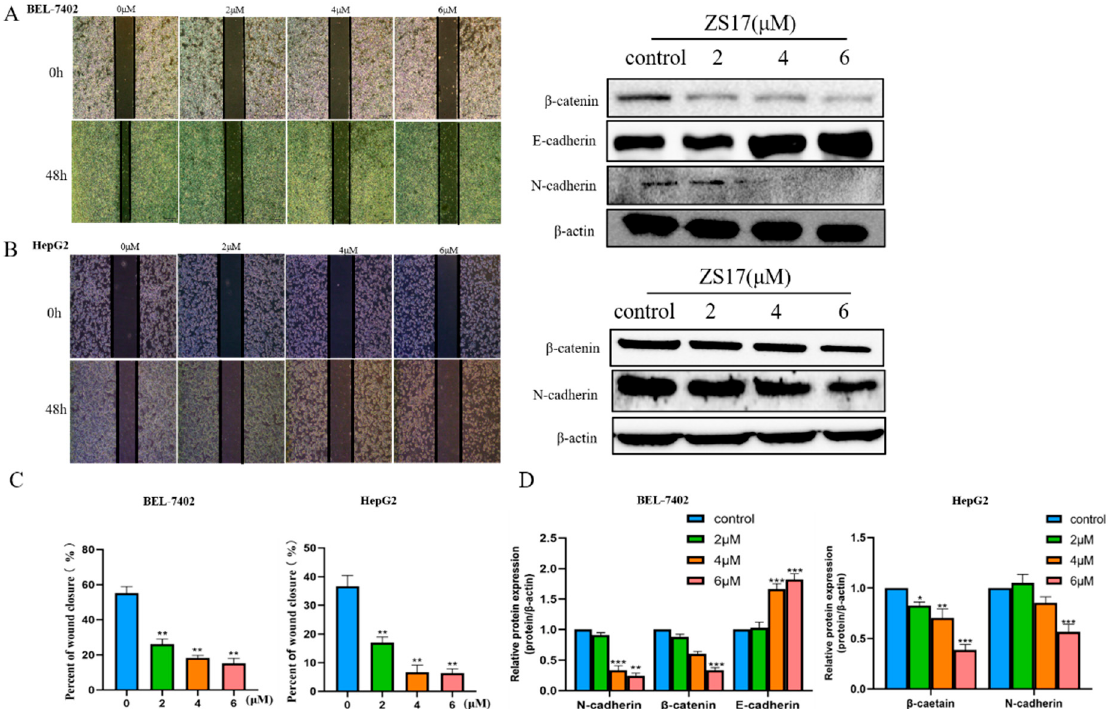
Figure 4. ZS17 inhibits cell proliferation. ( A , B ) The wound-healing assay was used to estimate the migration. ( C ) Wound-healing rate of cells induced by ZS17 . ( D ) Western blot analysis of the related proteins. Microscope’s magnification is 4×. Data are expressed as mean ± SD. Compared with model group: * p < 0.5, ** p < 0.01, *** p < 0.001. n = 3 per group.